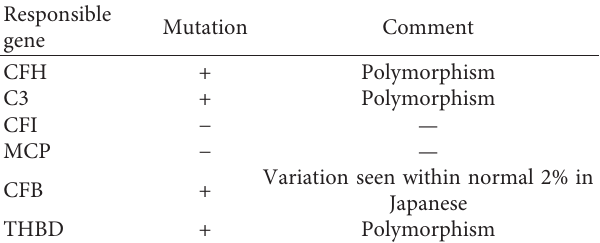
Table 1: Diagnostic tests for TMA-related disease.